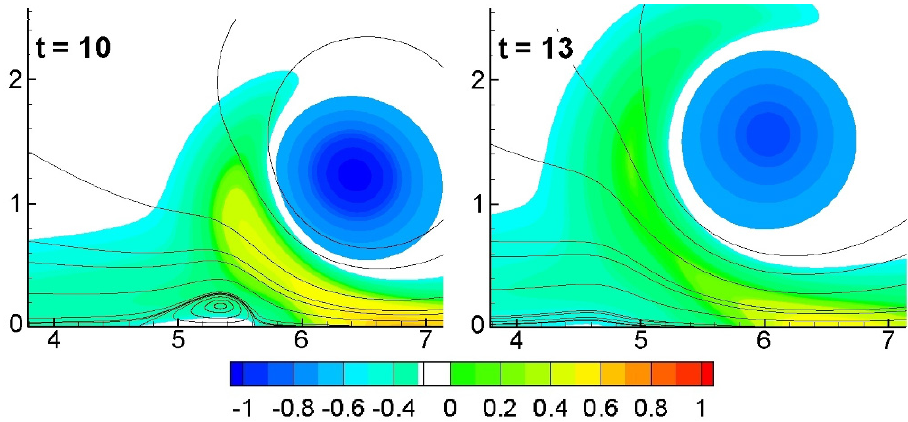
Figure 5. Interaction of the vortex patch and the wall for Re krI = 1000 . Near the wall, a new vortex structure is created, t = 10 . The Figure presents the vorticity field with selected streamlines.